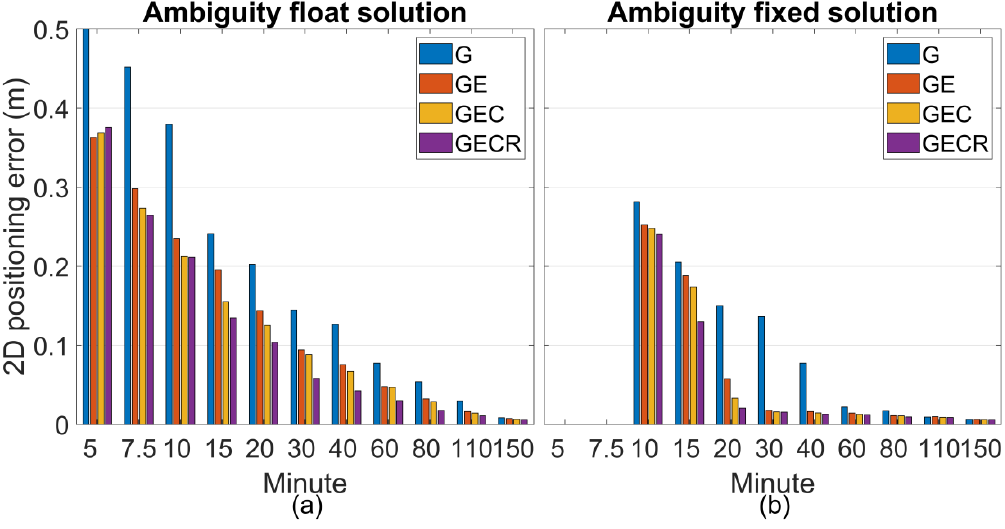
Figure7. ( a )Horizontalambiguityfloatpositioningerrorsand( b )horizontalambiguityfixedpositioning errors of di ff erent combinations in kinematic mode at specific minutes with a 90%